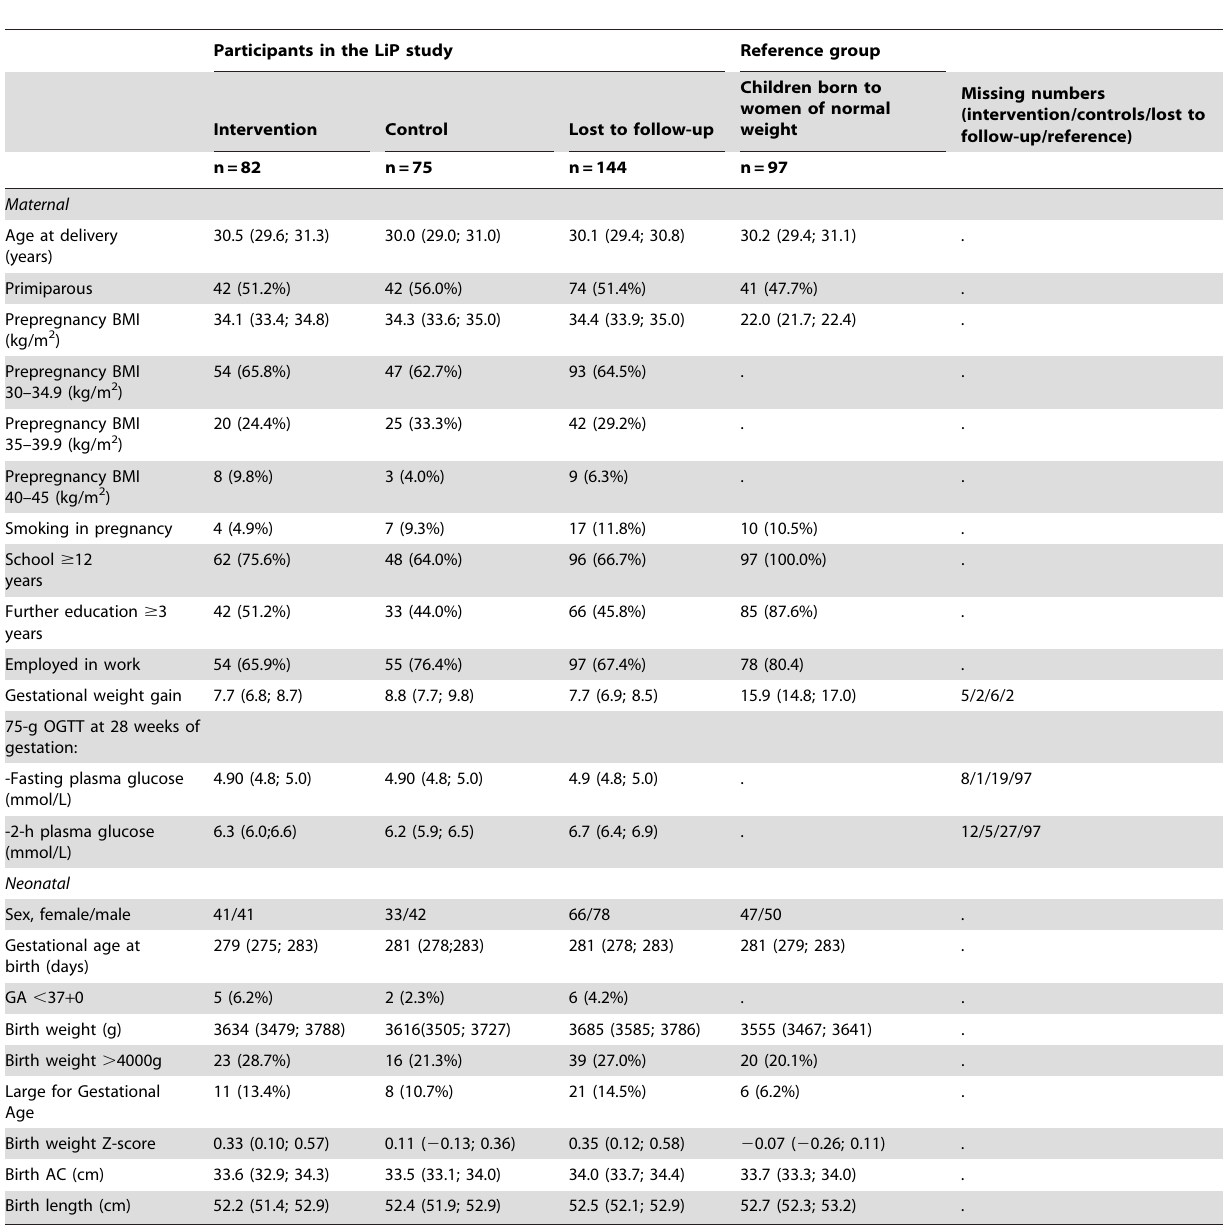
Table 1. Baseline, pregnancy and neonatal outcome data in trial groups from the LiP study and from a reference group of children born to women of normal weight.